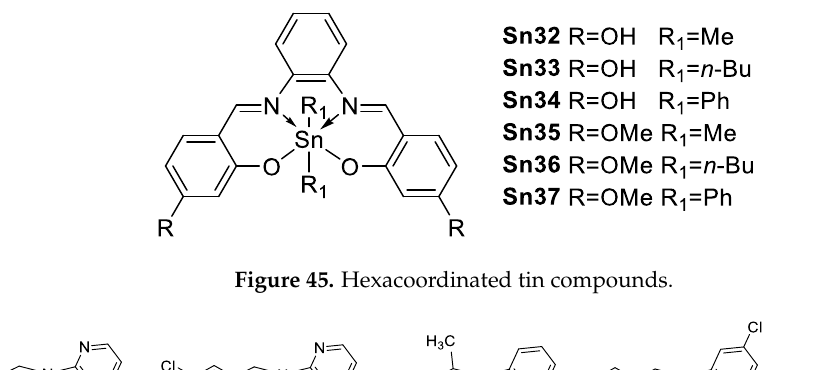
Figure 45. Hexacoordinated tin compounds.